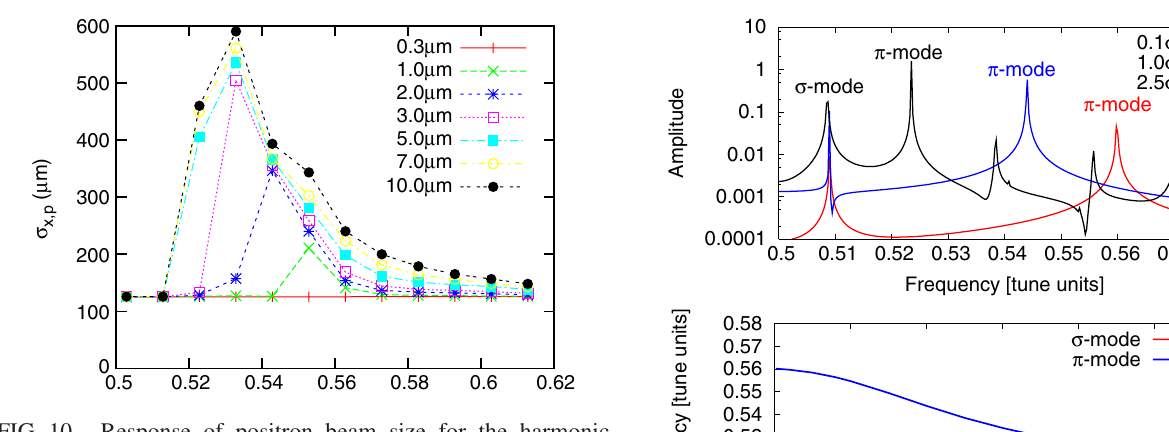
FIG. 10. Response of positron beam size for the harmonic excitation frequency and amplitude.